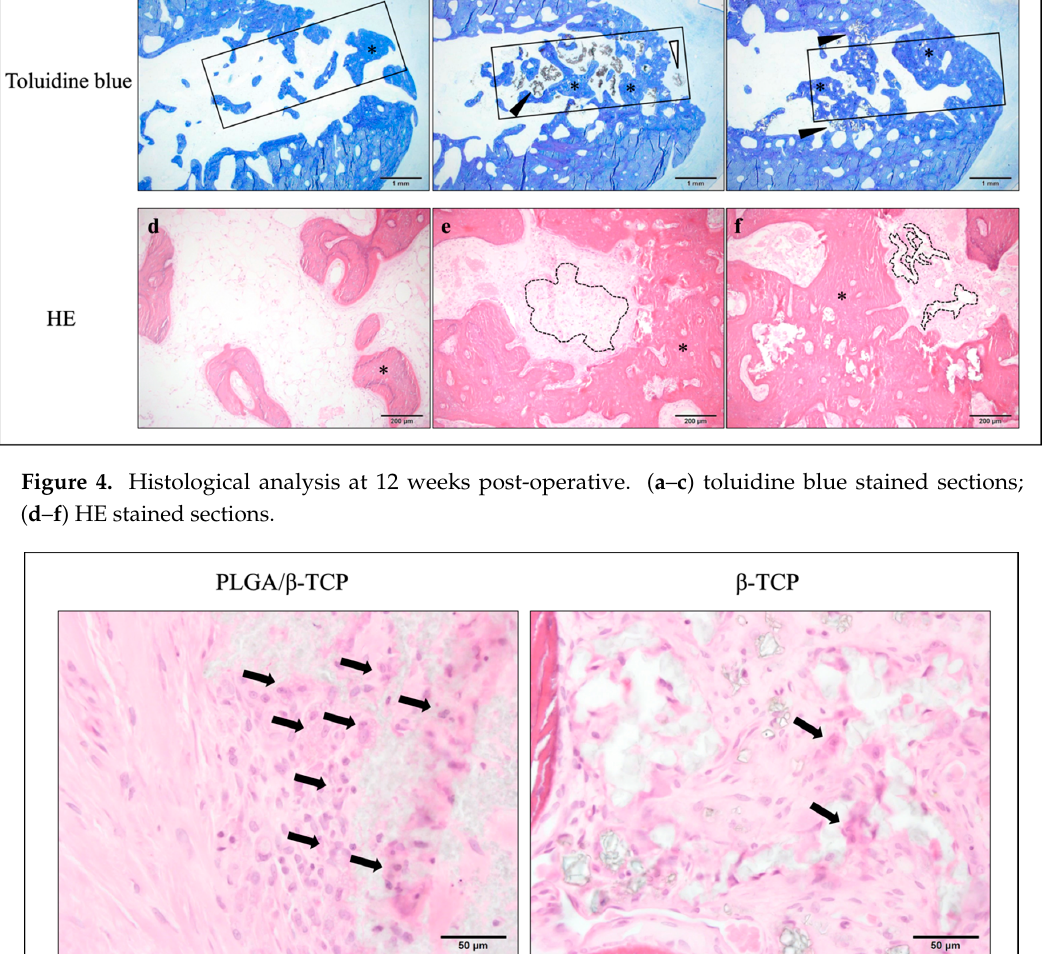
Figure 5. Higher magnification around bone substitute at 12 weeks post-operative.